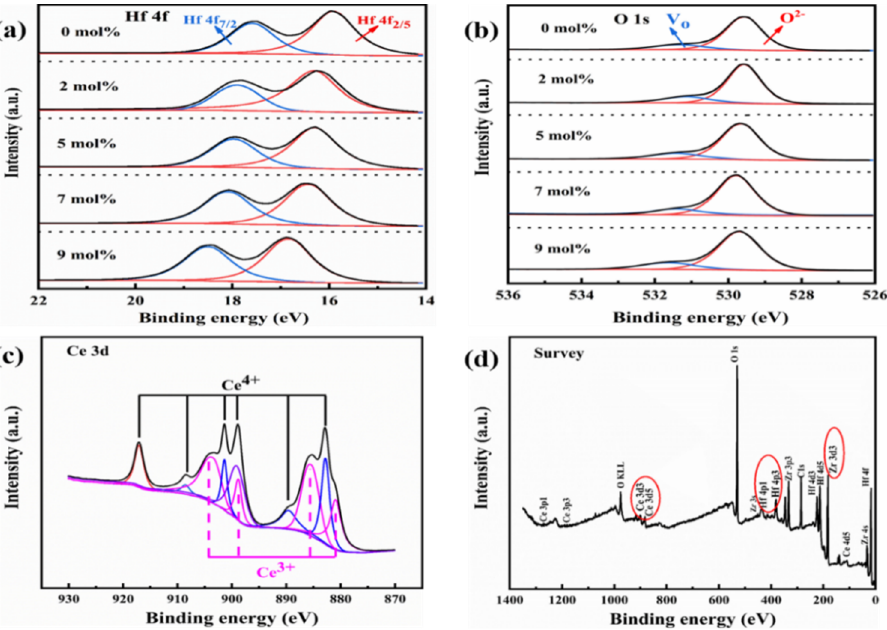
Figure 3. ( a ) High–resolution XPS spectra of Hf 4f and ( b ) O 1s core level with different Ce concentrations; ( c ) Ce 3d and ( d ) XPS survey spectra of 7 mol% Ce–doped films.